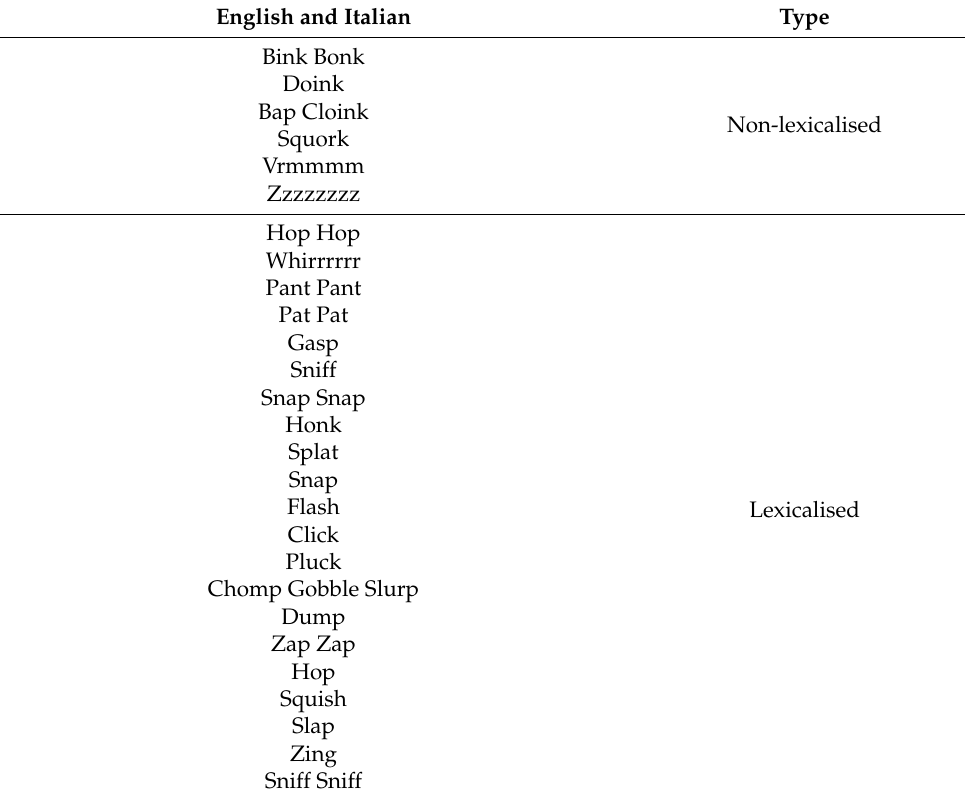
Table 1. List of ‘reproduction’